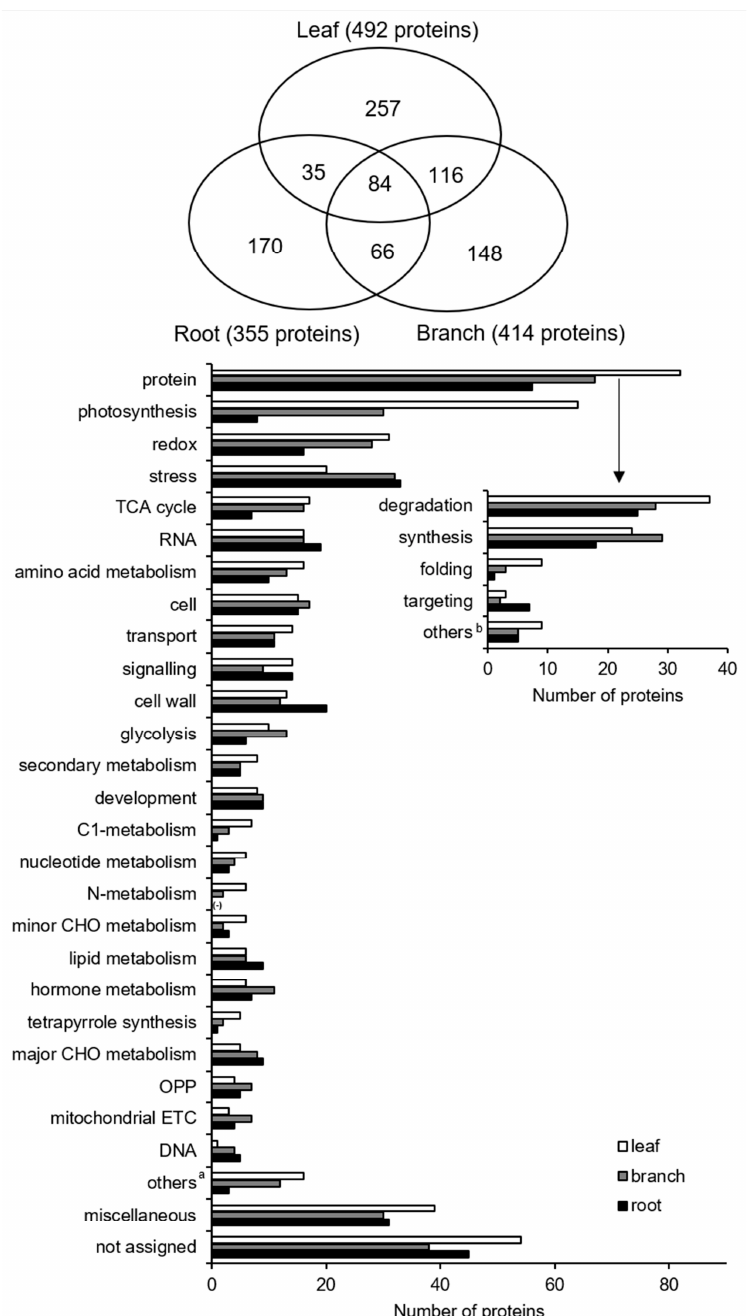
Figure 2. Functional categorization of proteins in leaf, branch, and root from Morus . Leaf (white), branch (gray), and root (black) samples were collected and proteins were extracted, digested, and analyzed by nanoLC-MS/MS. Protein functions were predicted and categorized using MapMan bin codes. Abbreviations: redox, redox ascorbate/glutathione metabolism; TCA, tricarboxylic acid; RNA, RNA processing and regulation of transcription; cell, cell organization, and vesicle transport; CHO, carbohydrates; OPP, oxidative pentose phosphate; ETC, electron transport chains; and DNA, DNA synthesis, and repair. a Others, containing biodegradation of xenobiotics, co-factor and vitamin metabolism, S-assimilation, gluconeogenesis, fermentation, and metal handling. b Others, containing amino acid activation, posttranslational modification, and assembly/cofactor ligation.